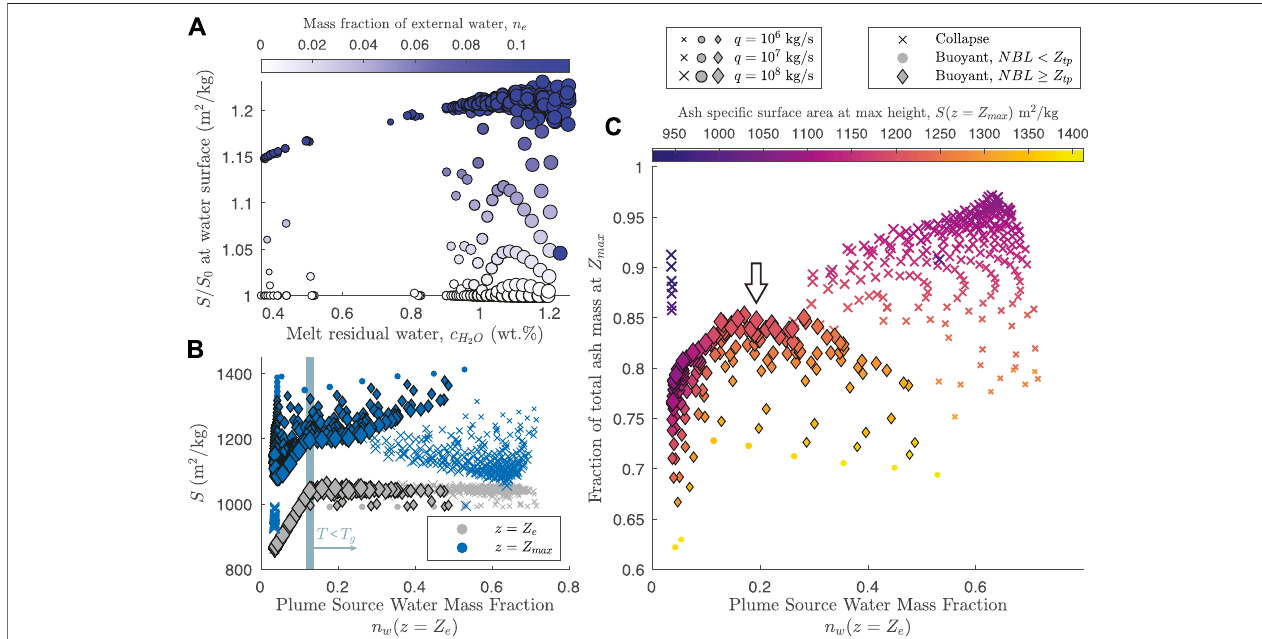
FIGURE11| EffectsofMWIandsedimentationonparticlespeci fi csurfacearea S . (A) Speci fi csurfacearea, S ,immediatelyafterthejetbreachesthewatersurface ( Z = Z e ),asa function of c H , thewatermass fraction still dissolved inthe melt after conduit exit. Symbolsare sized according toMERat the vent and colored according 2 O tothemassfractionofentrainedexternalwater.Thedissolvedwatercontentcontrolstheglasstransitiontemperature, T g ,whichinturnistheprimarylimitingfactorinthe model for how much surface area can be generated during quench fragmentation. (B) S at two different heights in the eruption column: at column source, immediatelyafterMWI( Z = Z e ,greysymbols),andatthecolumnmaximumheight( z = Z max ,bluesymbols)asafunctionofwatermassfractionatcolumnsource.Symbol sizes as in (A) . An ’ x ’ denotes a collapsing column, a fi lled circle denotes a column that is buoyant but with Neutral Buoyancy Level (NBL) below the tropopause, and diamonds are columns that are buoyant with NBL at or above the tropopause. Evolution from grey toblue symbols is aresult ofsedimentation over the rise height of the column.Theapproximatewatermassfractionabovewhichthepyroclastscoolbelowtheglasstransitiontemperature T g ismarkedwithaverticalbluebar. (C) Fractionof particlemassremaininginthecolumn atitsmaximumriseheightasafunctionofcolumnsourcewatermassfraction.Symbols aresizedbyMERasin (A,B) ,and colored according to the value of S at maximum column height. Symbol shapes as in (B) . The arrow highlights the subset of simulations with NBL above the tropopause and where the column retains increased (relative to “ dry ” runs) particle mass and speci fi c surface area.